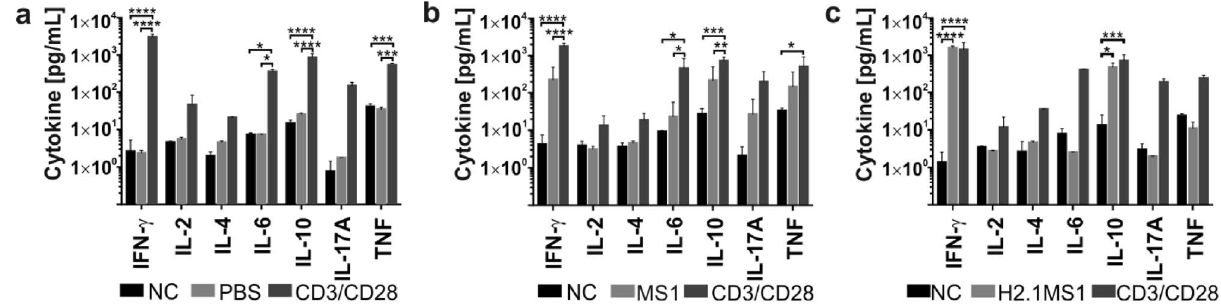
Figure 7. Cytokines secreted by restimulated splenocytes. Splenocytes were isolated from spleens 14 days after intravenous administration of PBS or MS1 or H2.1MS1 spheres. The cells were unstimulated (NC), stimulated with anti-CD3/CD28 antibodies (CD3/CD28), or in vivo challenge with ( a ) PBS (PBS), ( b ) MS1 spheres (MS1), or ( c ) H2.1MS1 particles (H2.1MS1). After 72 h, the cytokine concentrations in the samples collected above from the treated splenocytes were measured using cytometric bead array. The results are expressed as the means ± SD. ****Indicates significance with p ≤ 0.0001, *** p ≤ 0.001, ** p ≤ 0.01, and * p ≤